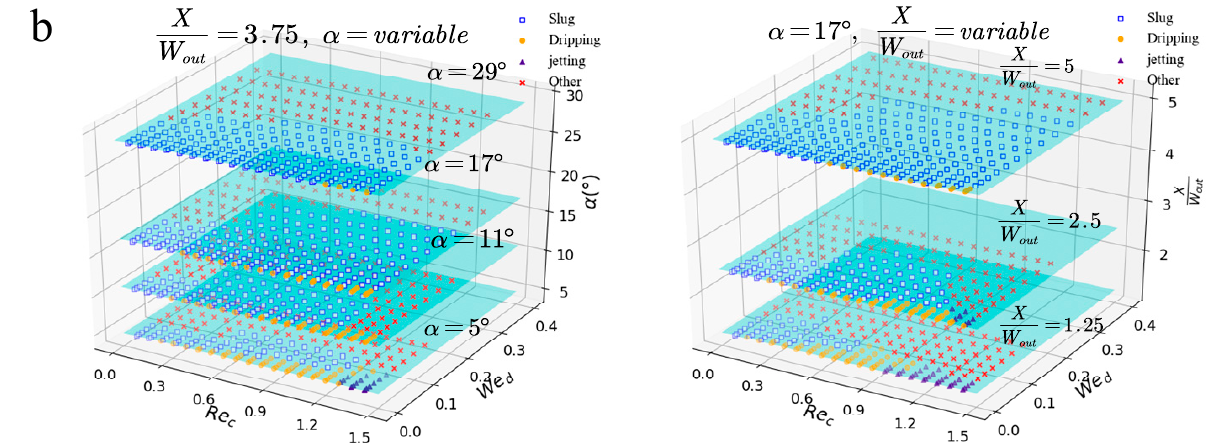
Figure 4. The flow patterns diagram of 2 group experiments: ( a ) Experiment 1, ( b ) Experiment 2.